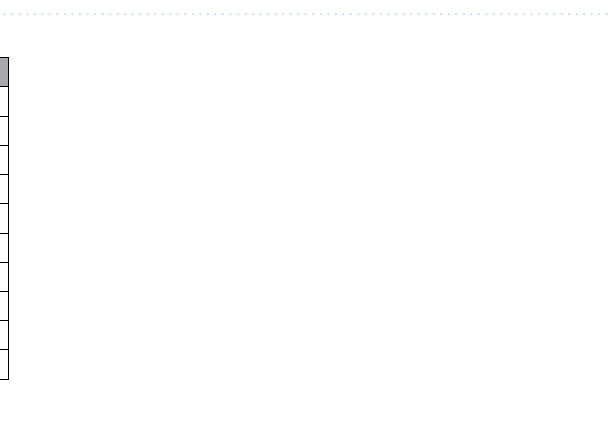
Figure 3. Simulated visualization of the nanoparticles with functional groups in a water system; ( a ) Green indicates the alkyl chain; ( b ) dark navy blue colour represents hydrogen and white represents oxygen; ( c ) Yellow–Red particles bonded together are CuO nanoclusters.